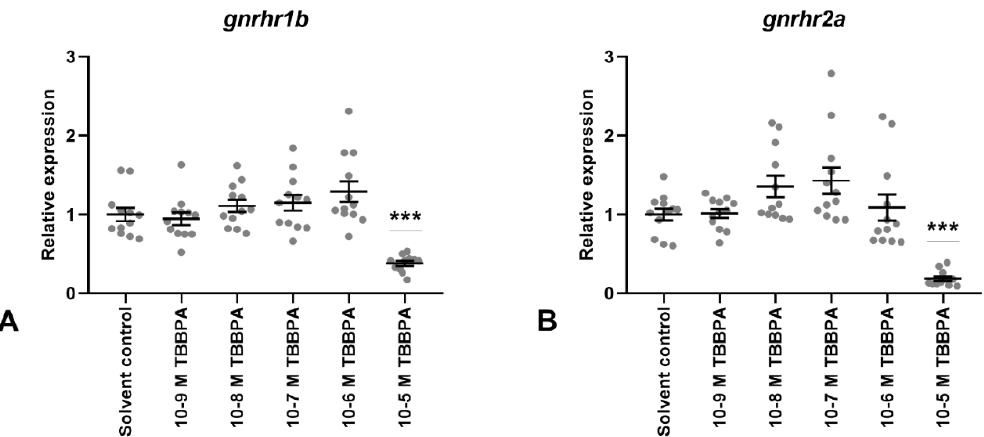
Kruskal – Wallis test followed by the Steel method.